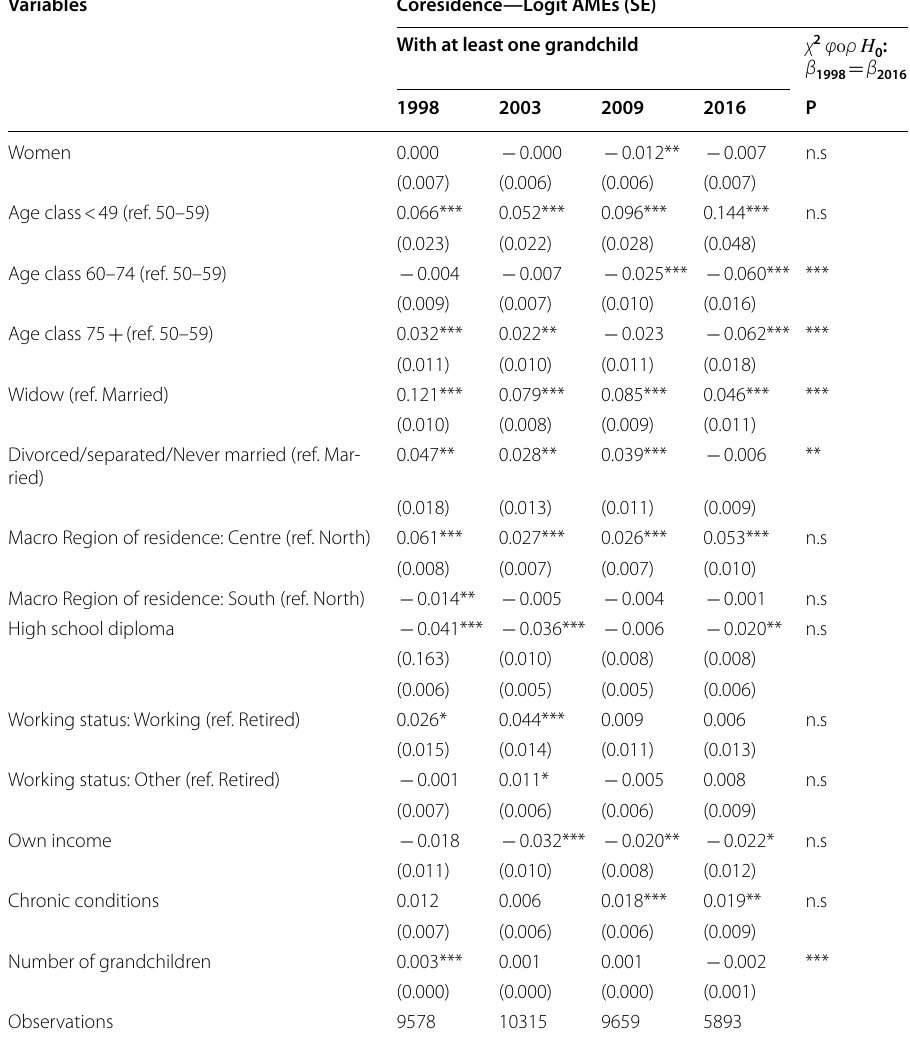
Table 2 Logistic regression models estimating the Average Marginal Effects (AMEs) of having at least one coresident grandchild among all grandparents by